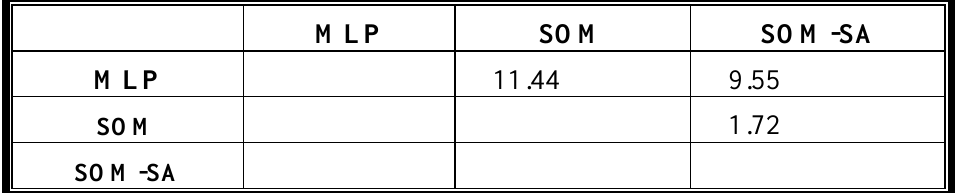
Table 6. Kappa analysis results for the comparisons of the three error